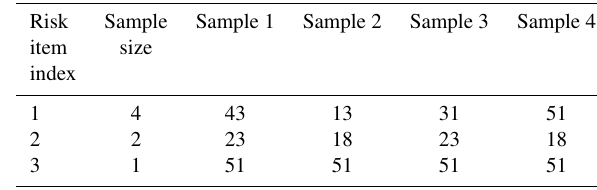
Table 2. Risk location index mapping table. Rows correspond to in- dividual risk items, showing sampled grid point indices. Each col- umn represents a possible spatial distribution of the portfolio. Risk item 1 has the maximum location sample size of n max = 4, but risk items 2 and 3 only have a sample size of 2 and 1,